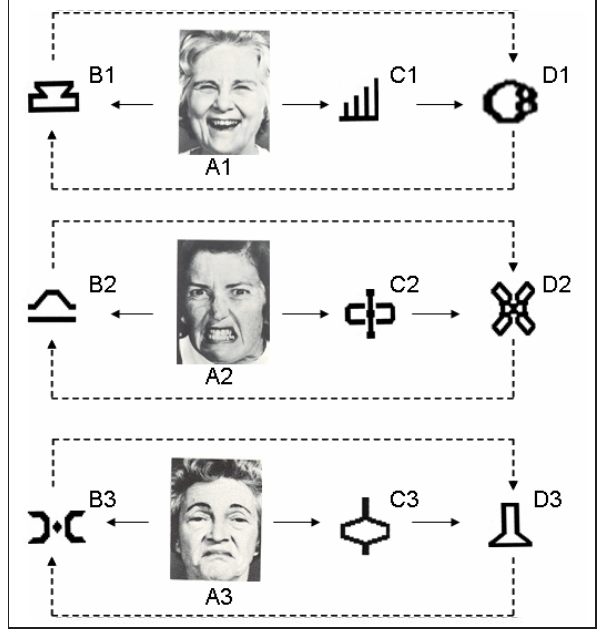
Figura 1. Representação esquemática das relações treinadas (setas contínuas) e testadas (setas tracejadas) na Fase